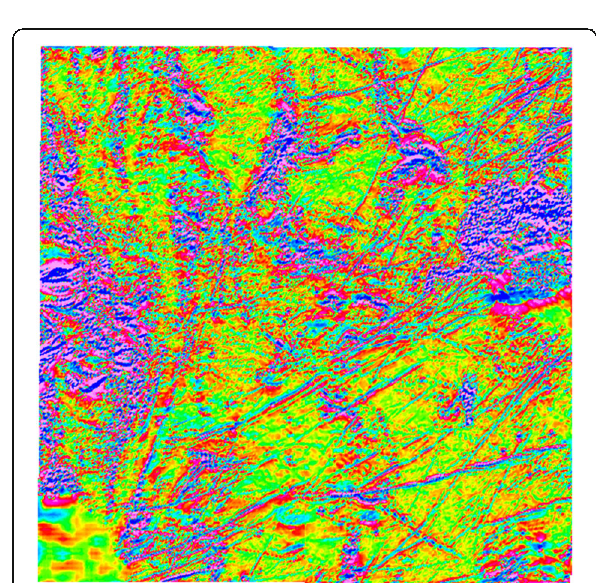
Fig. 8 Tilt derivative aeromagnetic image for the study area showing the major